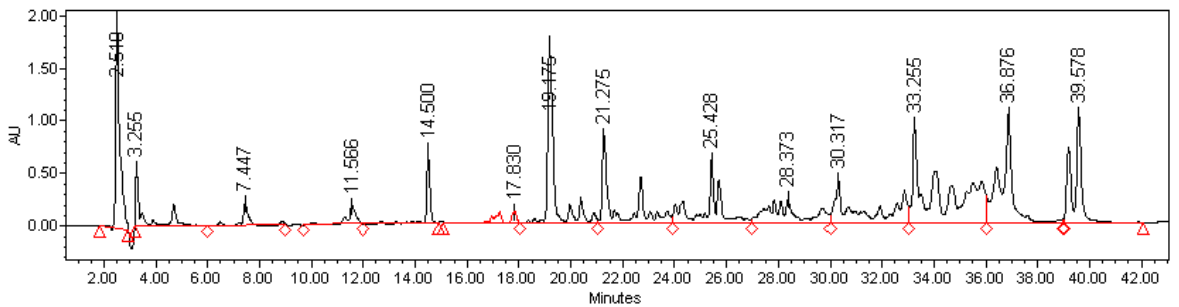
Figure 2. Chromatographic example of a peptide profile of an undigested cheese.